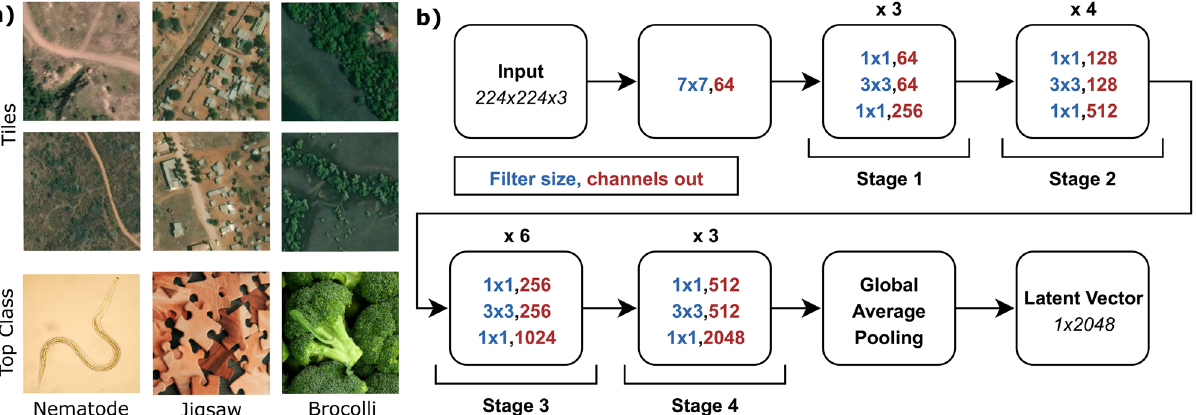
Figure 2. ResNet-50 ImageNet predictions and architecture. ( a ) ImageNet class predictions for very-high- resolution satellite image tiles. Although the classes are irrelevant, the network shows an intrinsic understanding of the difference between built-up area, vegetation, and road. ( b ) Diagram of ResNet-50 encoder. Residual blocks between Input and Global Average Pooling are comprised of convolutional layers with interleaved batch normalization